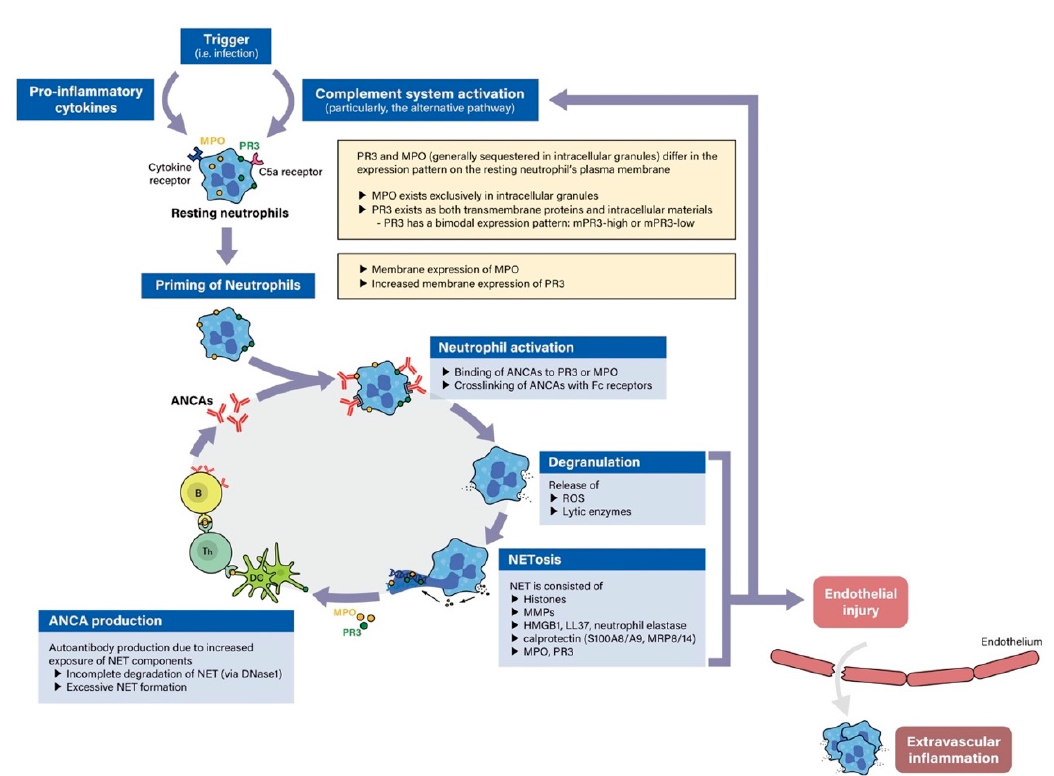
Figure 1. Pathogenesis of anti-neutrophil cytoplasmic antibody (ANCA)-associated vasculitis. An inflammatory trigger leads to increased membranous expression of myeloperoxidase (MPO) and proteinase 3 (PR3) on neutrophils. Binding of ANCAs to PR3 and MPO triggers neutrophil activation, degranulation, neutrophil extracellular trap (NET)osis, which further releases MPO and PR3 to prime ANCAs. Degranulation and NETosis contribute to endothelial injury and complement